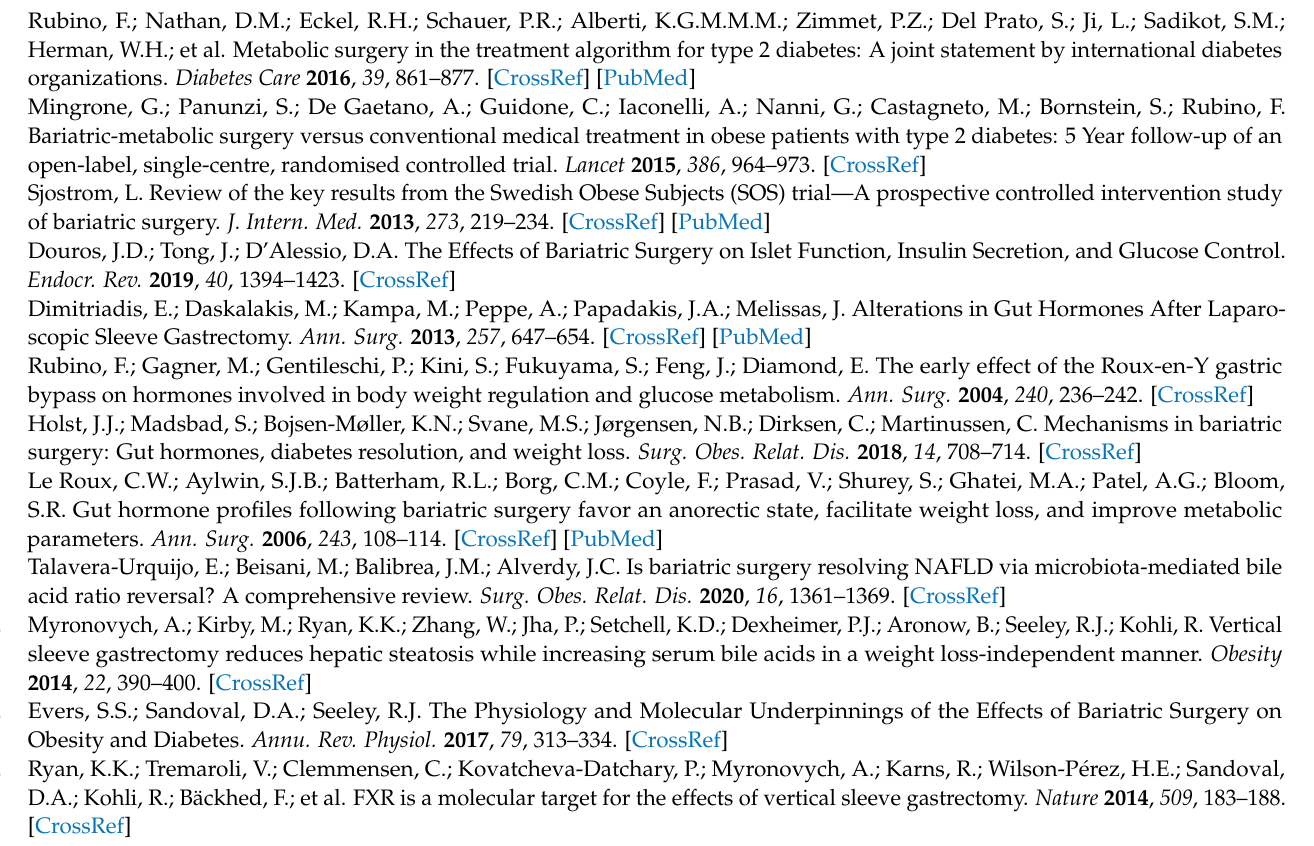
surgery type. Table S2: Pre-surgical characteristics of all patients in the registry and of the patients for whom two-year follow-up data on BMI, A1C, AST, and ALT were available. Table S3: Parameters for backwards elimination multivariate linear regression model for the change in AST levels two years after bariatric